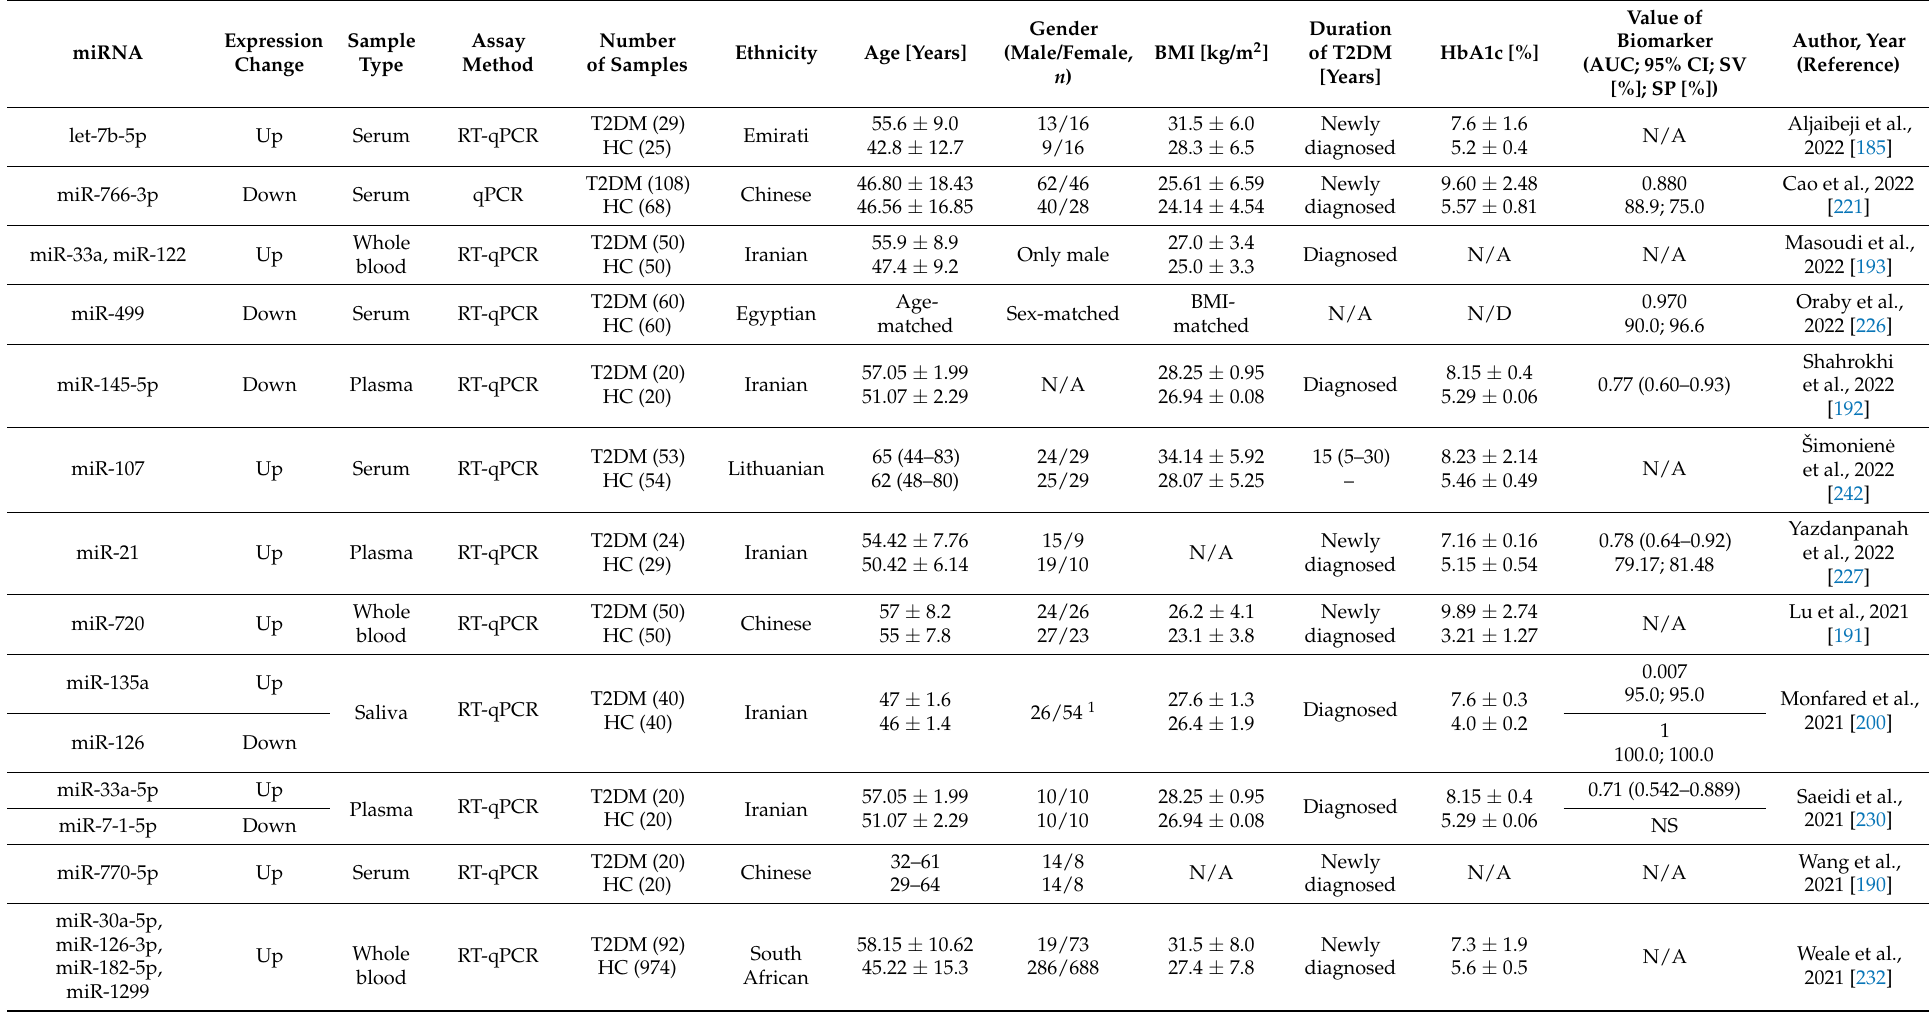
Table 1. Circulating microRNAs as potential biomarkers for type 2 diabetes